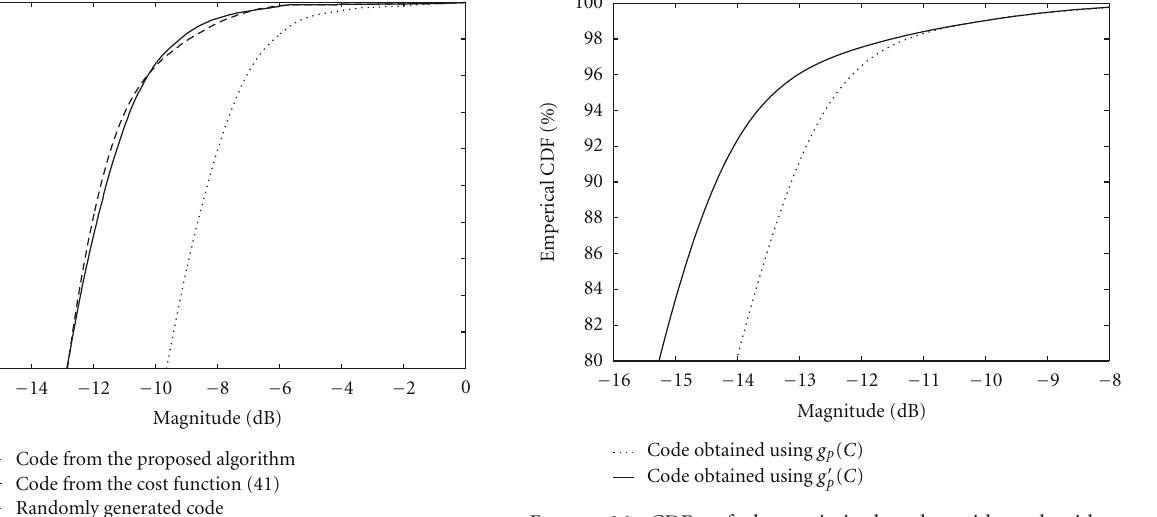
Figure 16: CDFs of the optimized codes with and without weighting in the specified region ( M = 4, Q = 10, K = 80, l max = 8, k max =